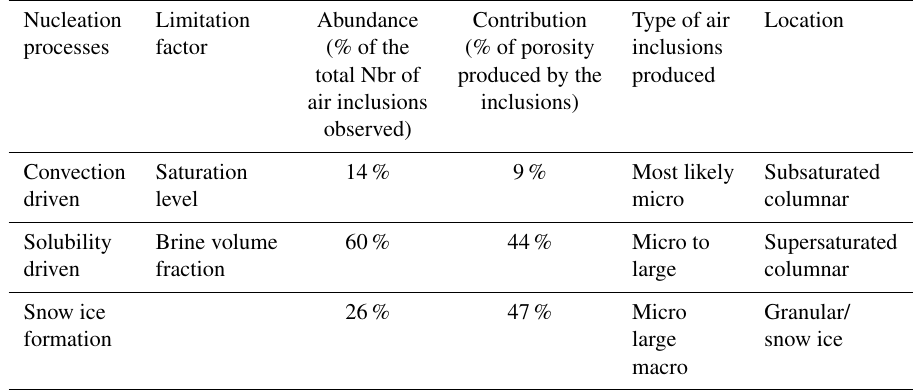
Table 6. Main parameters influencing the air volume fraction. The “abundance” is the proportion of the inclusions concerned by the processes on the total of inclusion observed (100% is the total of inclusions observed in the three data sets (14 Jan + 16 Jan + 25 Jan)). The “contri- bution” is the percentile of the porosity produced by the inclusions formed by convection driven, solubility driven and snow ice formation processes, respectively (100% is the total of air volume fraction observed in the three data sets (14 Jan + 16 Jan + 25